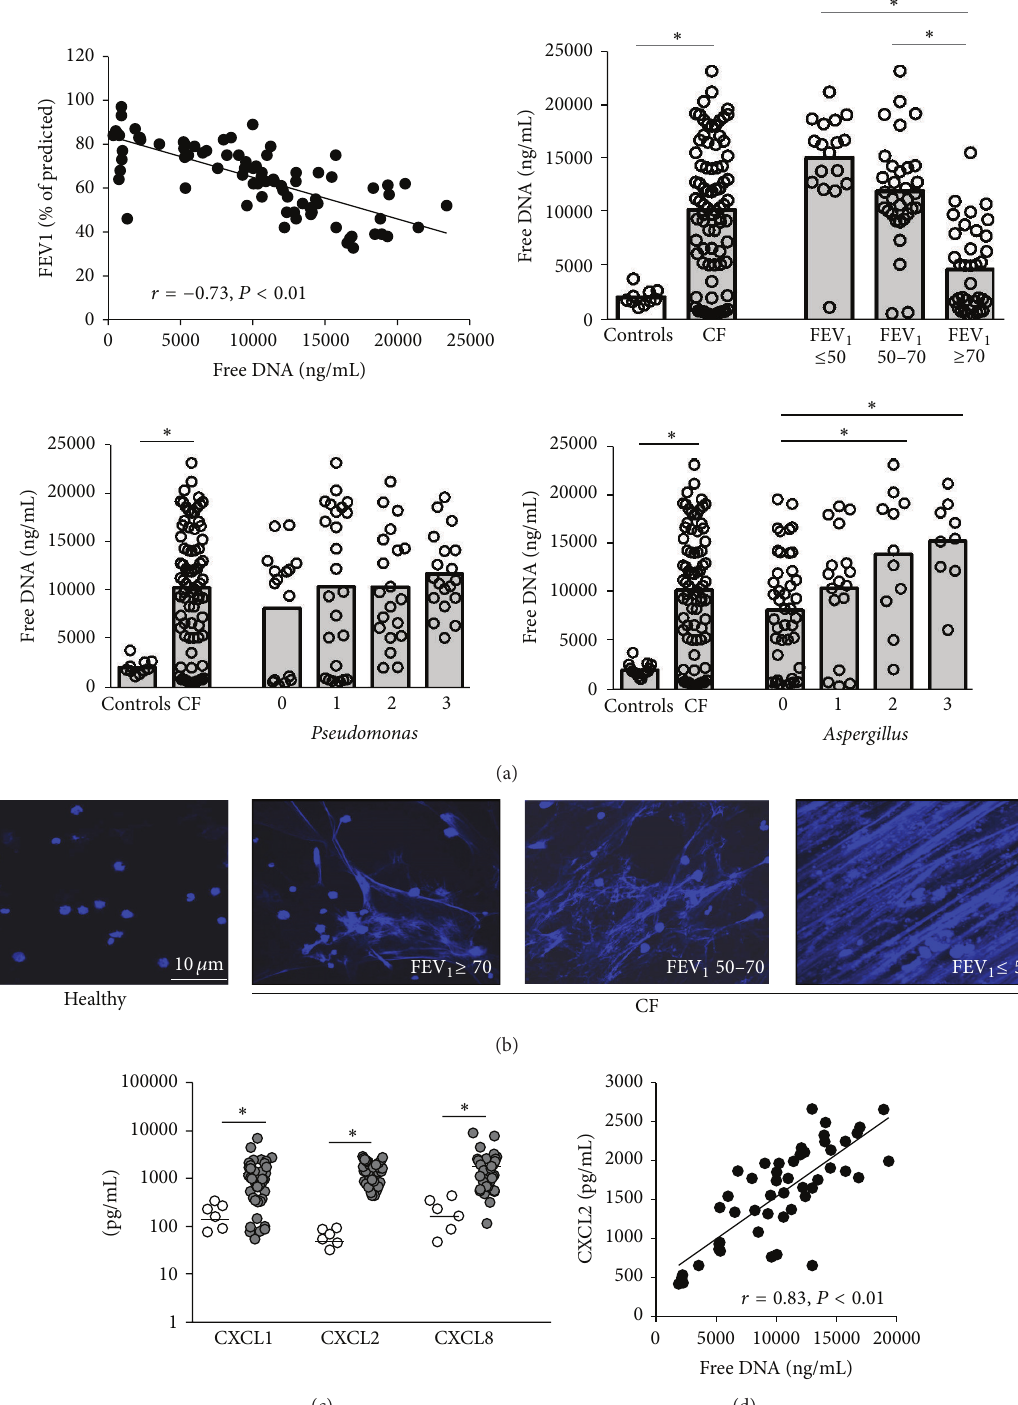
Figure 2: Free DNA, disease severity, and infection in CF lung disease. (a) Stratification of CF patients ( 𝑛 = 80 ). Upper left: correlation of free DNA levels with FEV 1 in sputum supernatants from CF patients. Upper right: free DNA levels in sputum supernatants from healthy controls and CF patients, stratified by FEV 1 . Lower panels: free DNA levels in sputum supernatants from healthy controls and CF patients, stratifiedby Pseudomonas aeruginosa or Aspergillus fumigatus infection/colonizationstatus( Leeds criteria, 0:never, 1:negative, 2: intermittent, and 3: chronic). (b) Representative CLSM images of airway fluids from one healthy individual and three different CF patients, stratified for lung function, are depicted. Scale bar: 10 𝜇 m; FEV 1 : forced expiratory volume in 1 second (% of prediction). DAPI staining of nuclei and extracellular DNA strands in CF sputa. (c) Chemokine levels in sputum supernatants from healthy controls (white, 𝑛 = 6 ) or CF patients (grey, 𝑛 = 50 ). (d) Correlation of free DNA with CXCL2 levels in airway fluids (cell-free sputum supernatants) from CF patients ( 𝑛 = 50 ). ∗ 𝑃 < 0.05